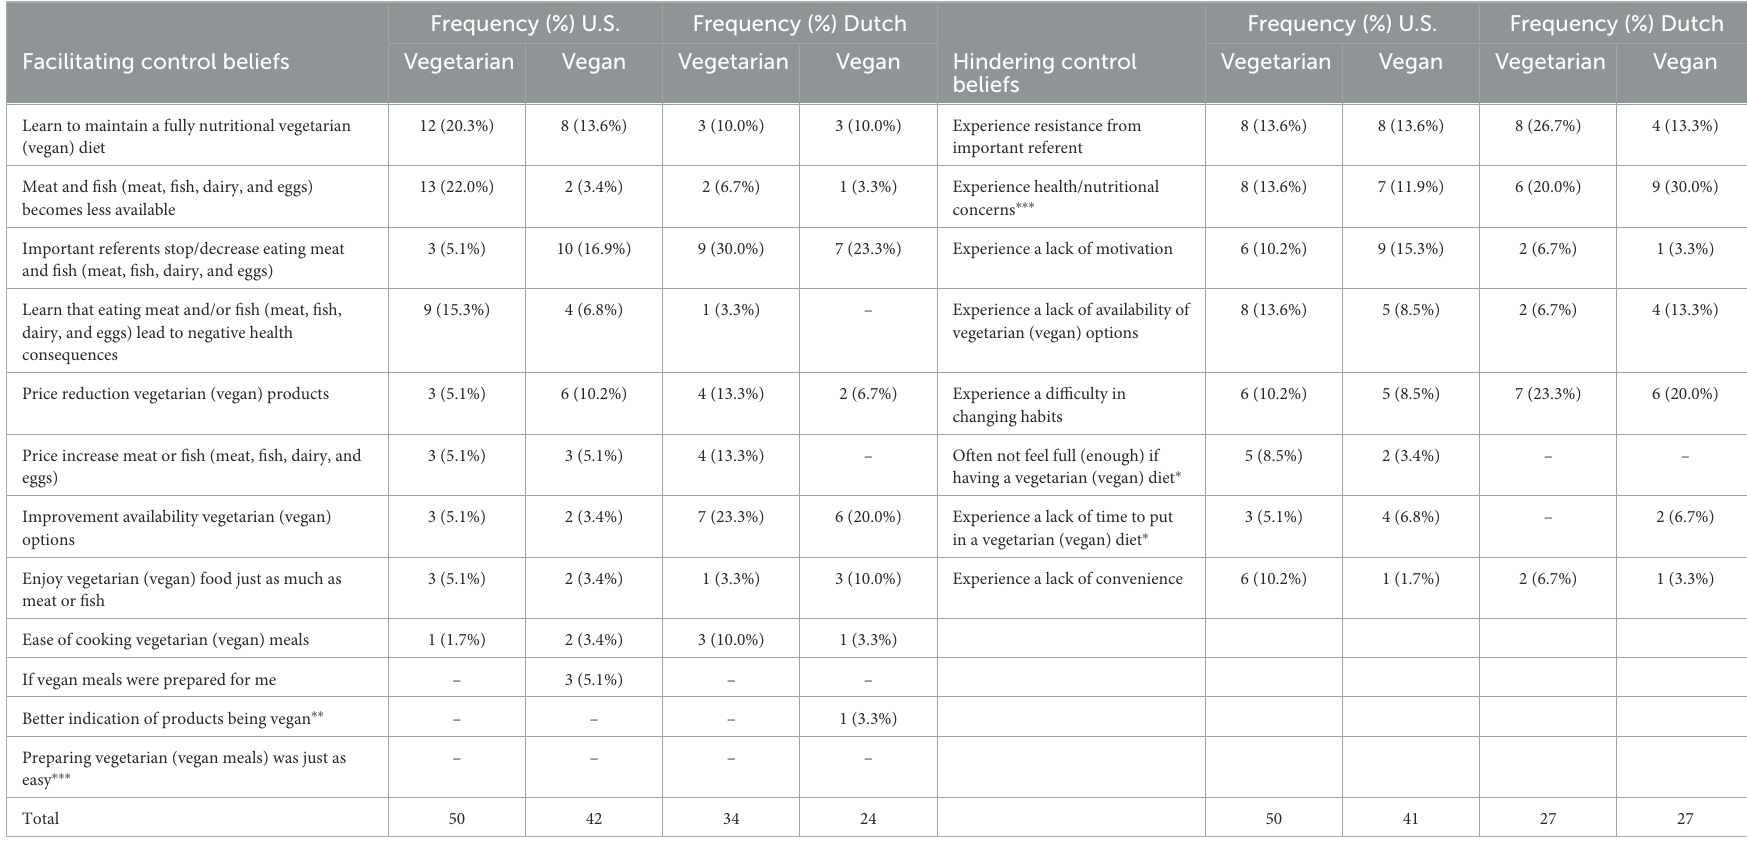
TABLE 2C Results belief elicitation questionnaire: most frequently mentioned (% of participants mentioned) control beliefs U.S. and Dutch sample. Frequency (%) U.S. Frequency (%) Dutch Frequency (%)